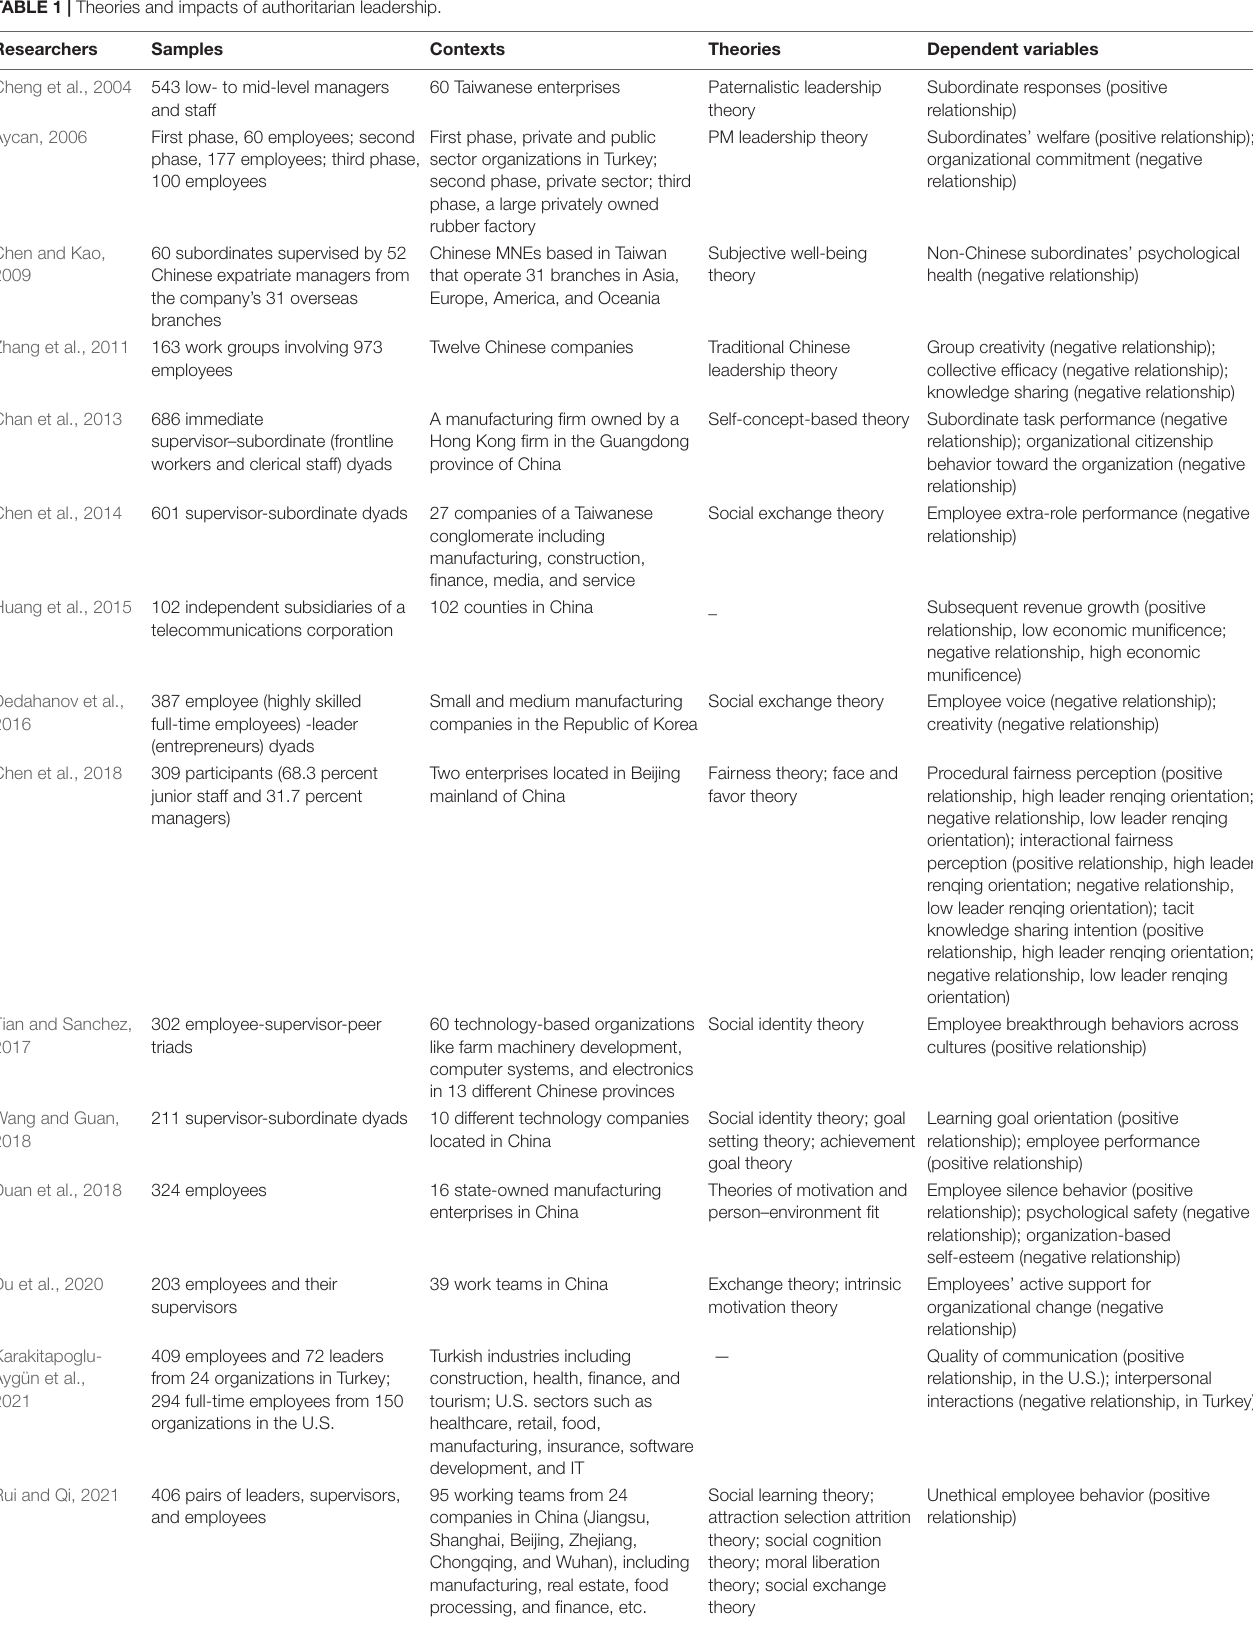
TABLE 1 | Theories and impacts of authoritarian